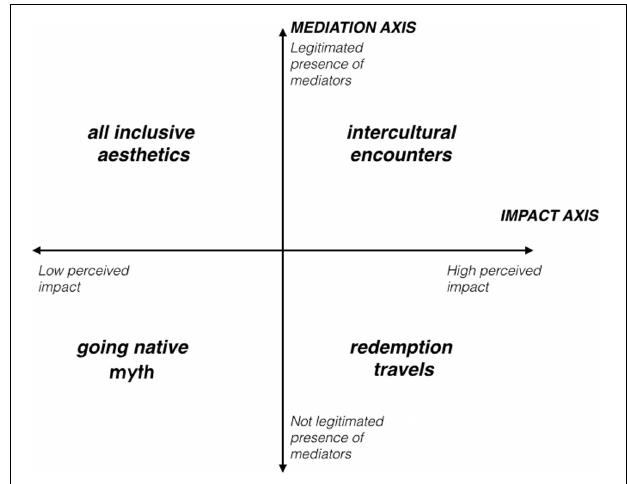
FIGURE 1 | Tourism sustainability